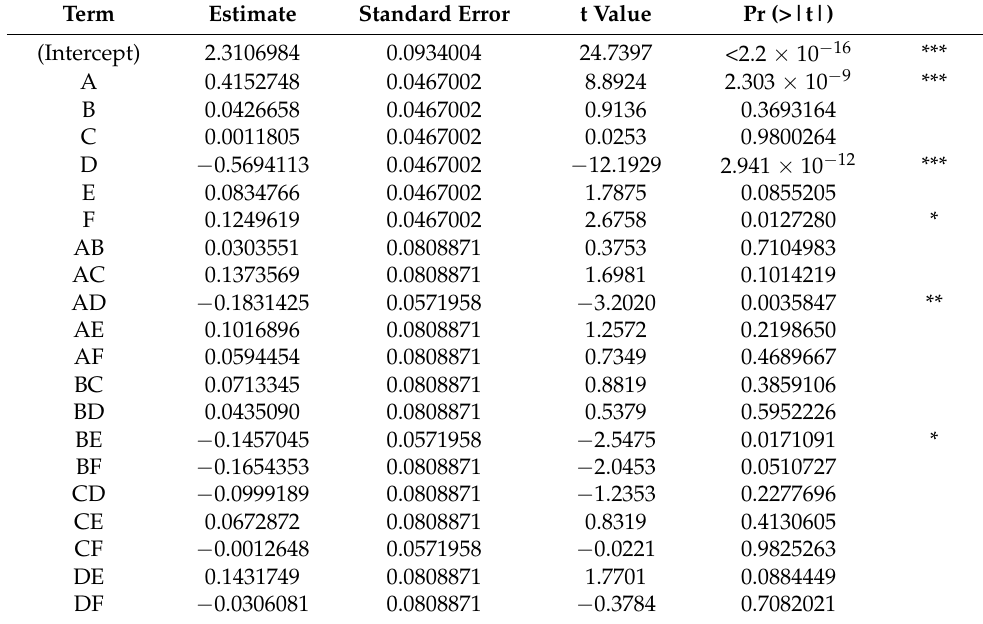
Table 1. Results of regression analysis of Box-Behnken